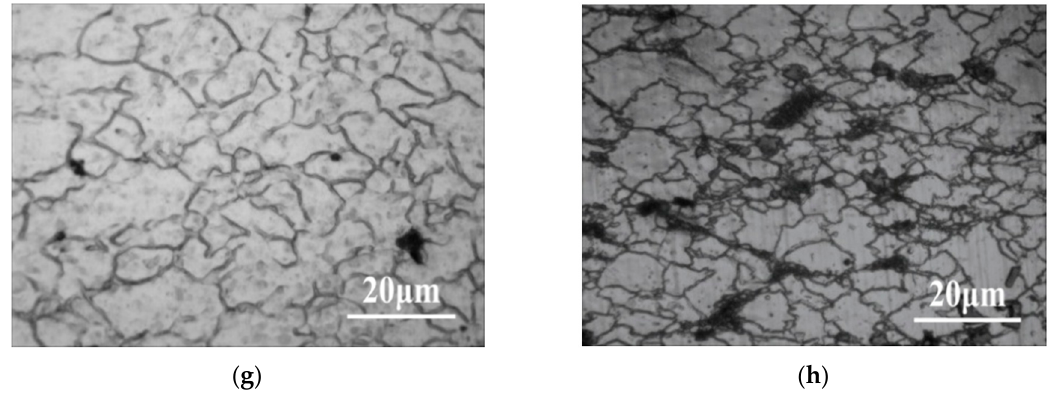
Figure 4. OM images of ( a , c , e , g ) AZ91 alloy, ( b , d , f , h ) composite after hot compression: ( a , b ) 523 K, 1 s − 1 ; ( c , d ) 523 K, 0.01 s − 1 ; ( e , f ) 623 K, 1 s − 1 ; ( g , h ) 623 K, 0.001 s − 1 .